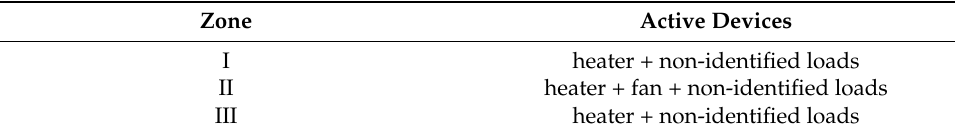
Table 2. Active devices of the V í tor SPP in each zone.